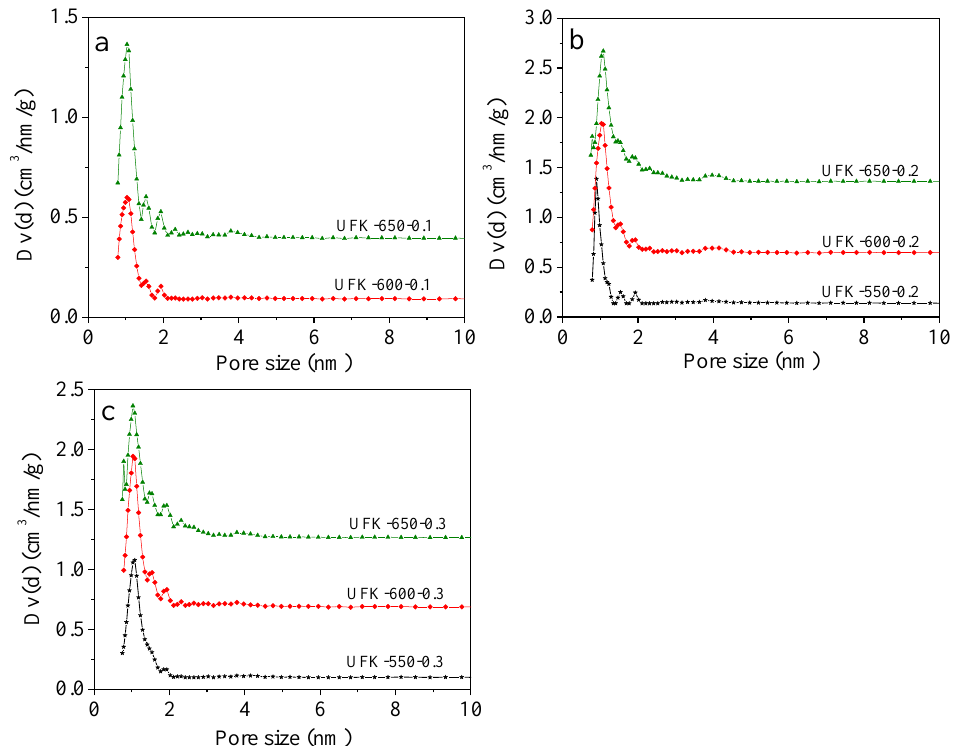
Figure 4. Pore size distribution of the samples prepared at KOH/UF mass ratio of ( a ) 0.1, ( b ) 0.2 and ( c ) 0.3. Due to the almost non-porous nature of UFK-550-0.1, its PSD is not shown here.